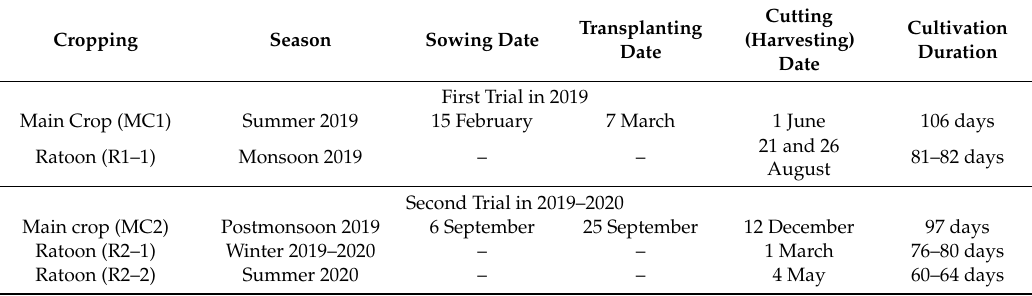
Table 1. Cultivation information for the main crop and ratoon rice.